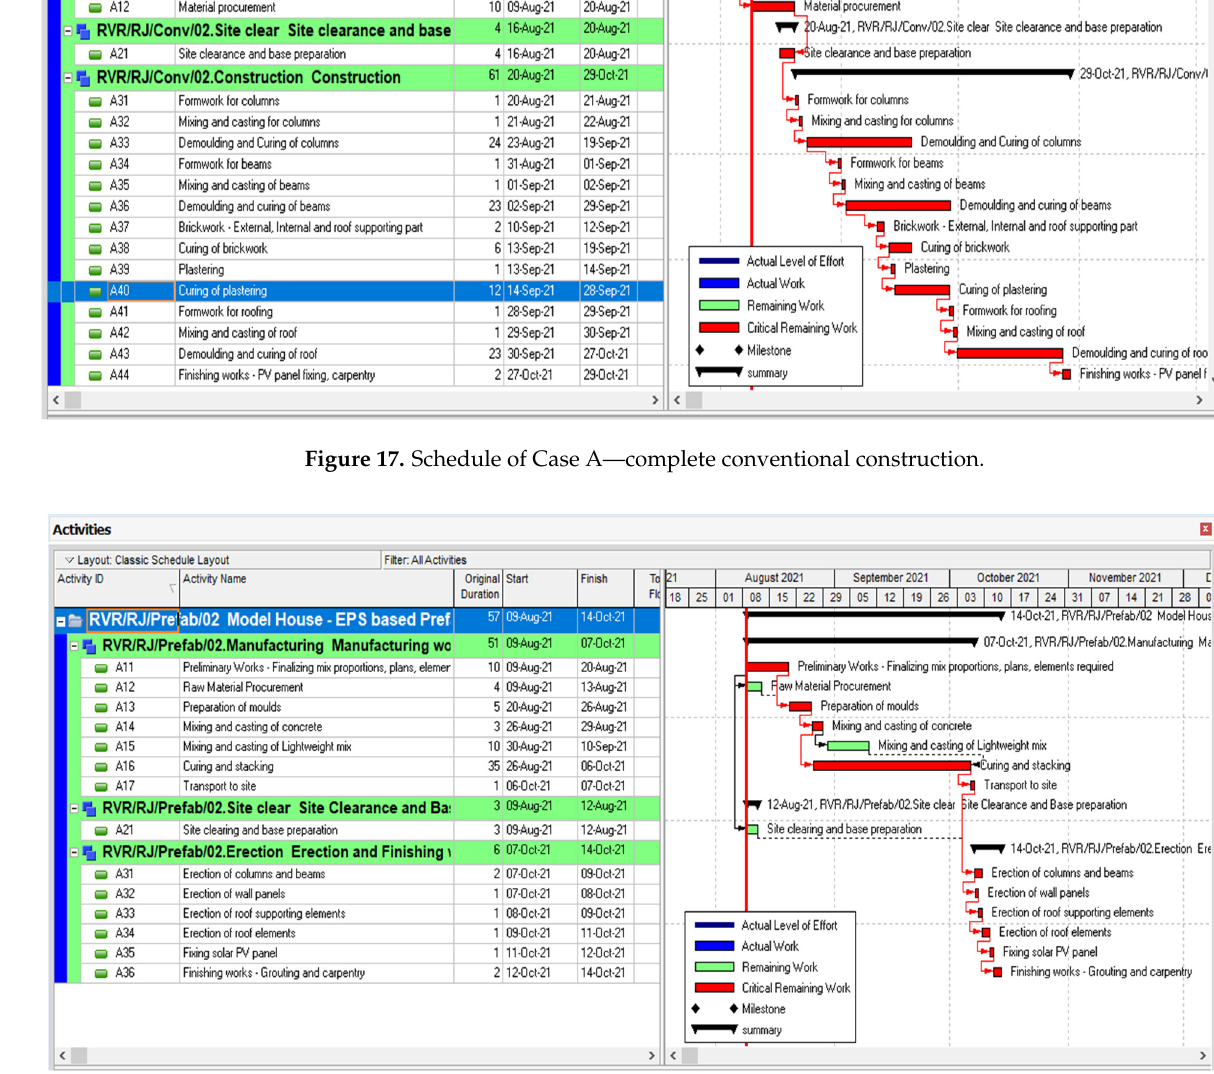
Figure 18. Schedule of Case B—complete prefabricated construction.